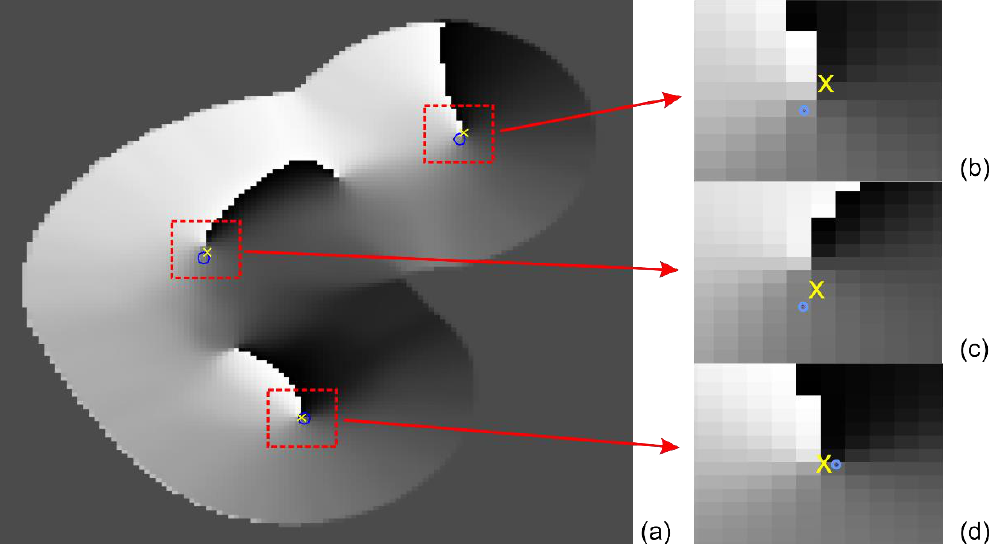
Figure 12. Experimental results with a separated optical vortex with the topological charge of m = 3. ( a ) Pseudo-phase profile, ( b – d ) enlarged fragments for three vortex points. The yellow “x” indicates a point found by the procedure using artificial neural networks, while the blue circle indicates the minimum intensity found on the basis of the procedure described in Section 3.